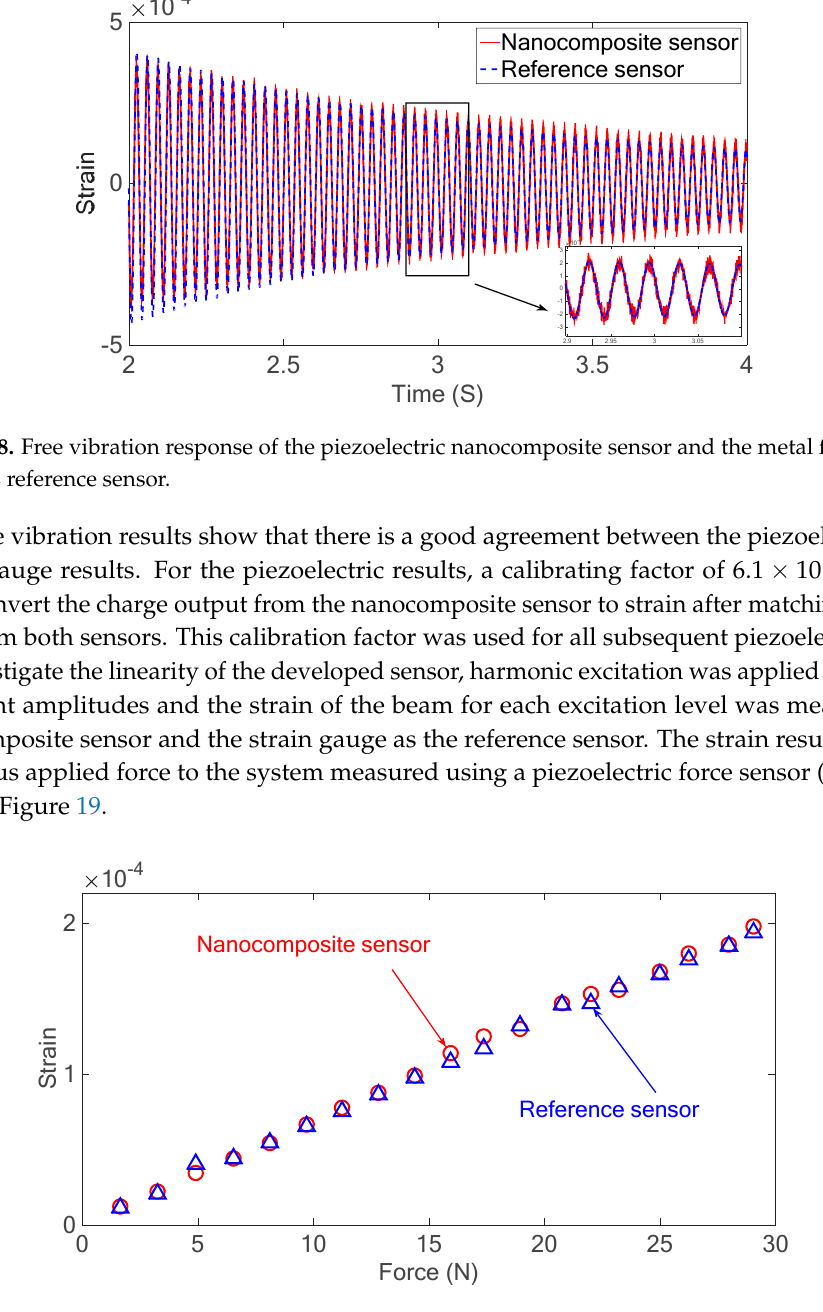
18 of 24 Figure 17. The piezoresistive response of the system under static loading obtained from the nanocomposite sensor and the metal foil strain gauge. The results obtained prove that there is a good agreement between the results of piezoresistive sensor and the metal foil strain gauge as reference sensor in static measurements. However, there is a small deviation between the results that can be attributed to the electric connections, i.e., the copper tape used in this study. Also, the nanocomposite sensor is attached to the beam using double ‐ sided tape, while the strain gauge sensor is attached using super glue. Therefore, when a static force is applied to the system, the reference sensors react to this change immediately, but the difference in the bond properties of the double ‐ sided tape does not allow the nanocomposite sensor to follow the behavior of the reference sensor accurately enough. The above results also show that the developed sensor can detect the sign of the strain. When the force is applied upward at the end of the cantilever resulting in negative strain, the resistance of the sensor decreases due to decrease of the distance between the CNT networks. Similarly, the length of the strain gauge decreases when a force is applied upward resulting in lower resistance in the sensor. The calibration factor for the piezoresistive sensor was picked 1.5 (cid:3400) 10 (cid:2879)(cid:2871) 𝑉 (cid:2879)(cid:2869) and this calibration constant was used for the free and forced vibration tests.